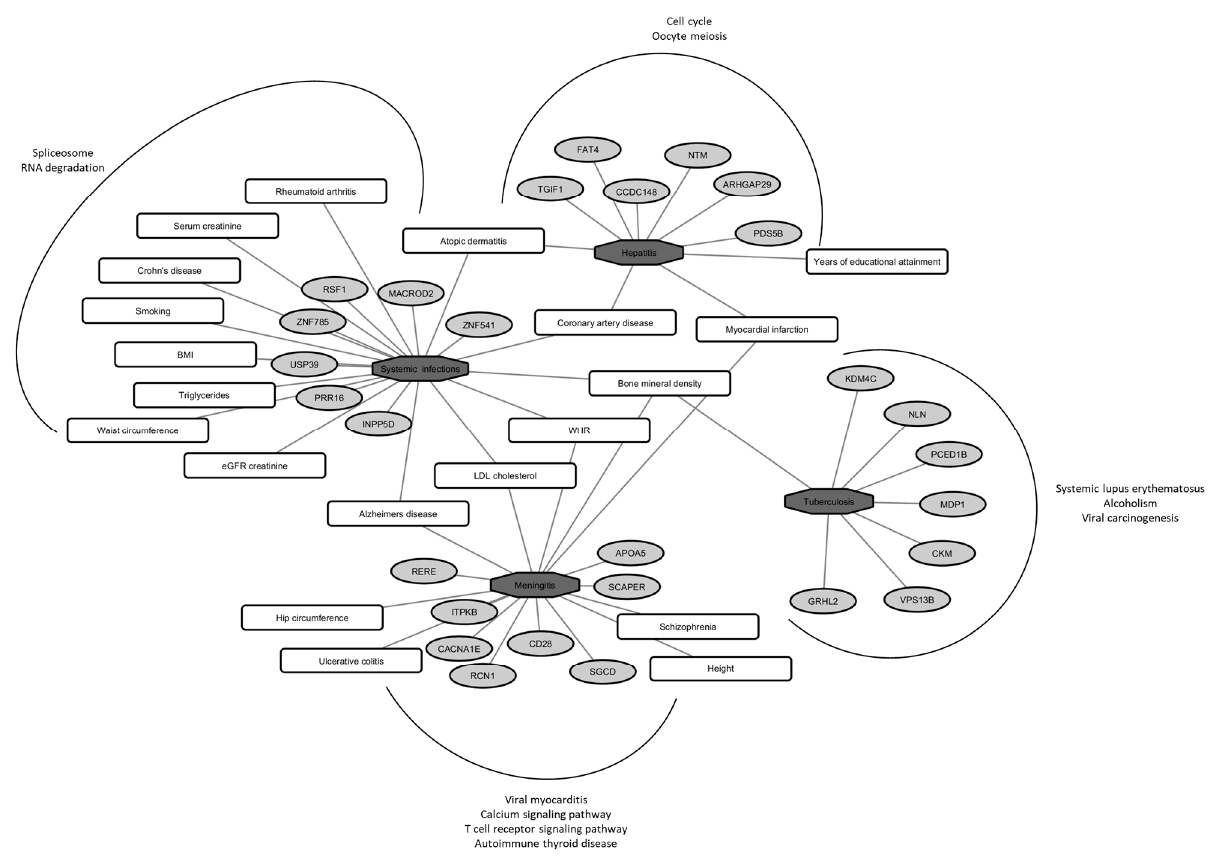
Figure 1. Pleiotropic network of identified loci (light grey oval shaped) with various infectious traits (dark grey octagon shaped) after a genome-wide meta-analysis of 4624 participants from the 10,001 Dalmatians biobank. Associations with various complex traits from other published GWA scans are shown in rounded rectangles, and KEGG pathway enrichment with an FDR cutoff of 1% for each of the infectious traits is depicted outside of the curved line (WHR—waist-to-hip ratio; BMI—body mass index; LDL—low-density lipoprotein; eGFR—estimated glomerular filtration rate).